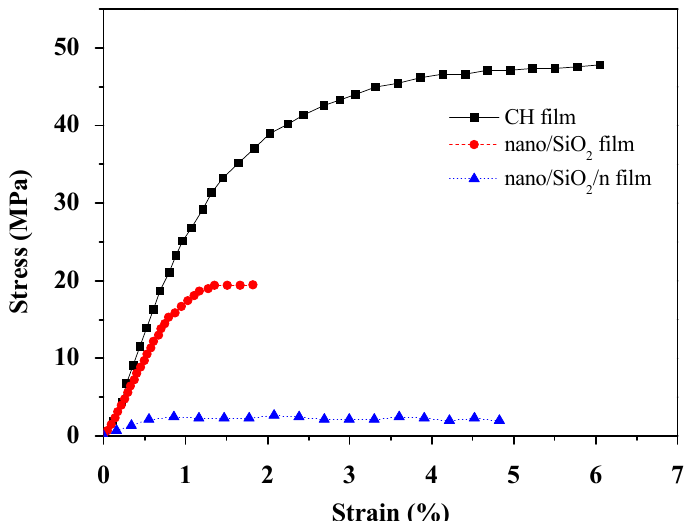
Figure 3. Tensile strength analysis for different novel films.